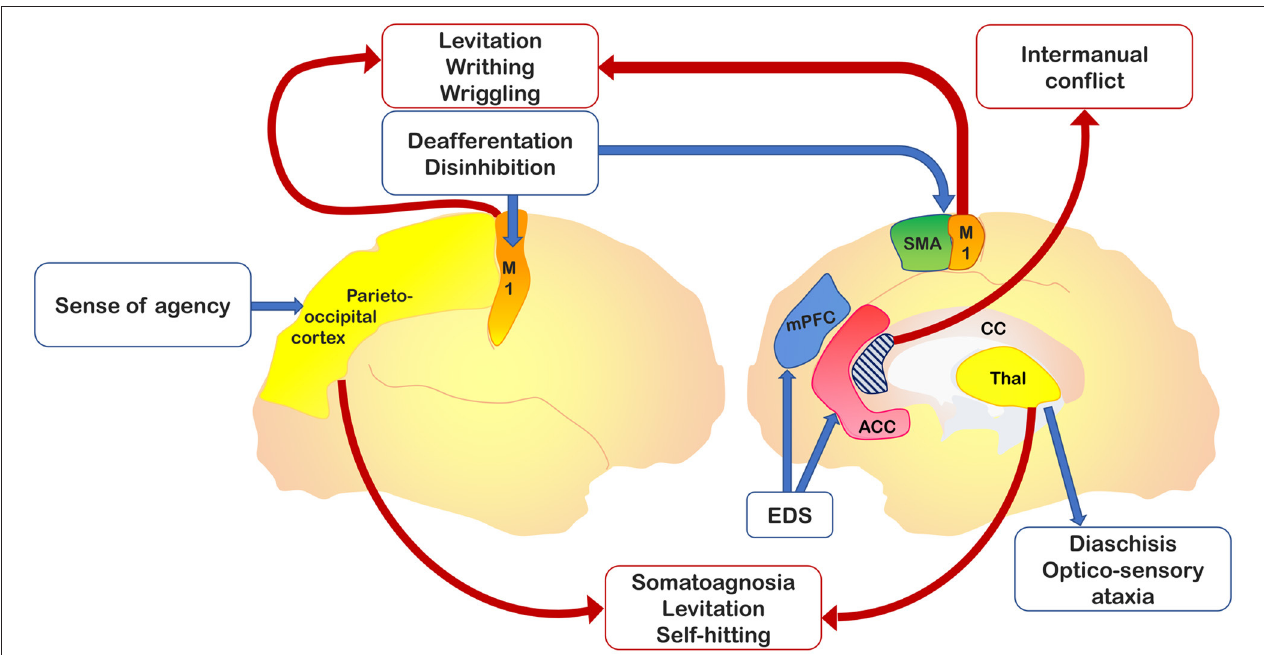
FIGURE 1 | Relevant brain areas associated with alien hand–alien limb (AH-AL) variants and motor control. In yellow, the parieto-occipital and thalamic regions, which are damaged in posterior variant; in dark blue, the medial prefrontal cortex, impaired in the frontal variant; in light blue, the corpus callosum, whose anterior region is involved into the callosal variant; in orange, the primary motor cortex, whose isolated activation has been documented in involuntary movements; in green, the supplementary motor area (SMA) involved in internal drives of motor planning; and in red, the anterior cingulate cortex, implicated in action